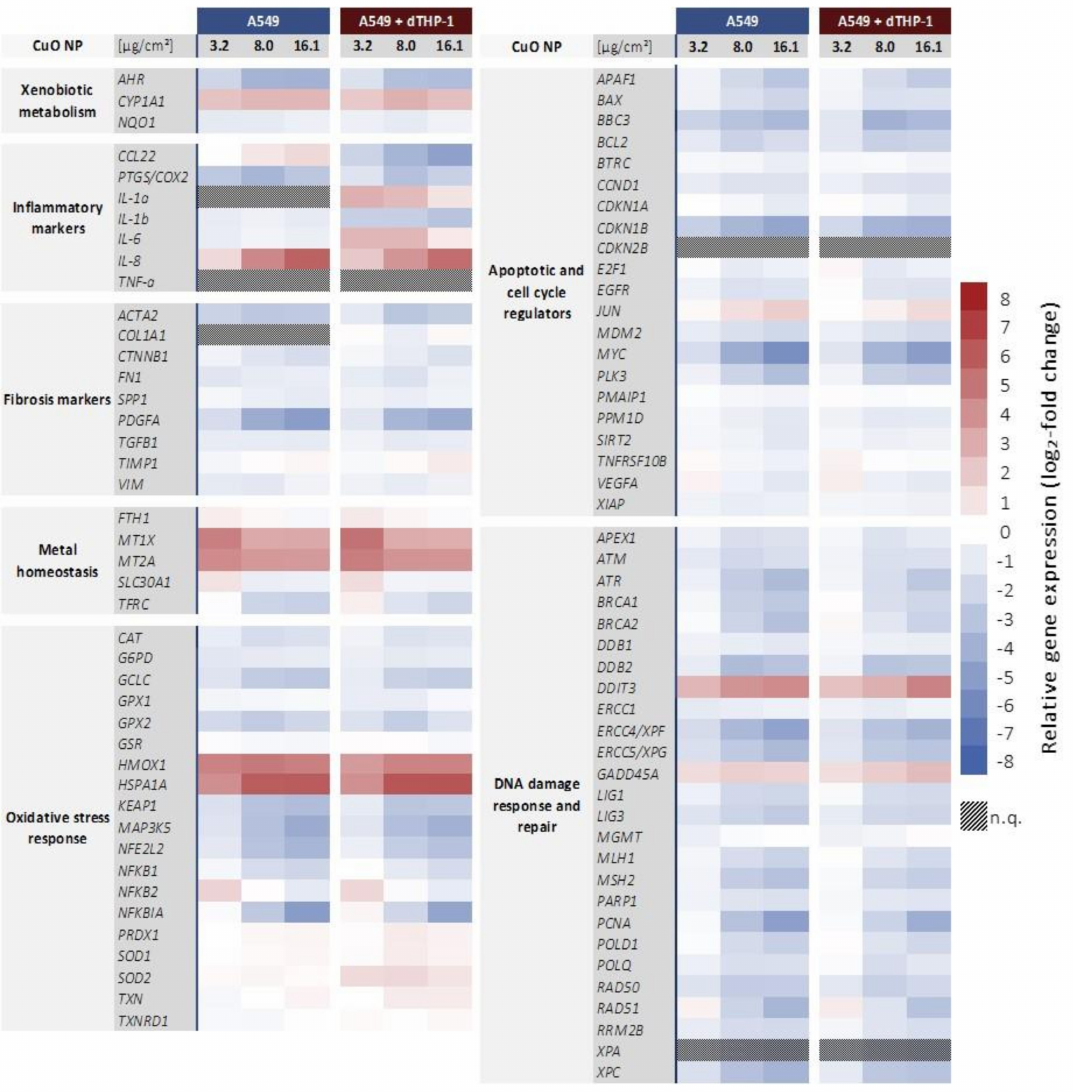
Figure 4. Overview of the impact of CuO NP on A549 cells cultured in monoculture or in co-culture with dTHP-1 cells using a high-throughput RT-qPCR approach with a custom-designed gene set. The genes under investigation have been clustered into groups associated with xenobiotic metabolism, inflammation, fibrosis, metal homeostasis, oxidative stress response, apoptosis, and cell cycle regulation as well as DNA damage response and repair. Both cell models were treated with CuO NP for 24 h. Displayed are the log 2 -fold changes of relative gene expression as a heatmap. Red colors indicate an enhanced expression, and blue colors indicate a down-regulation. Shown are the mean values of at least three independently conducted experiments. n.q.: not quantifiable due to low expression